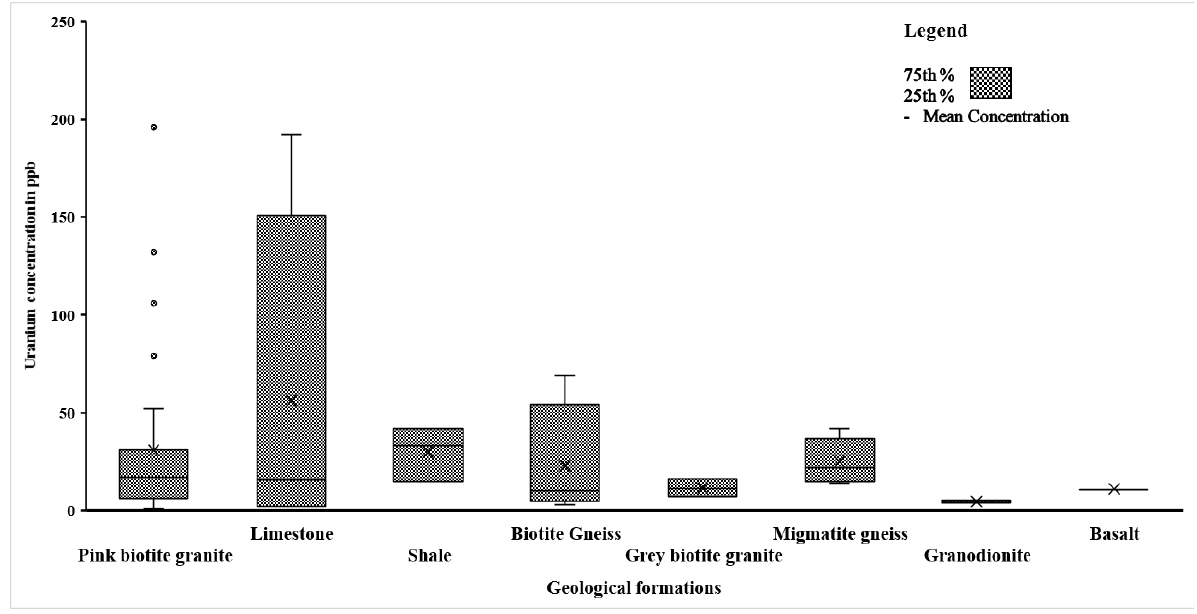
Figure 10. Uranium concentration in groundwater of wells located in different rock types.